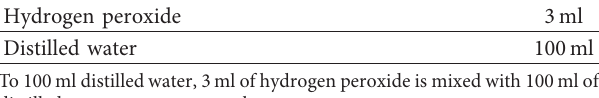
Table 11: Preparation of catalase reagent.